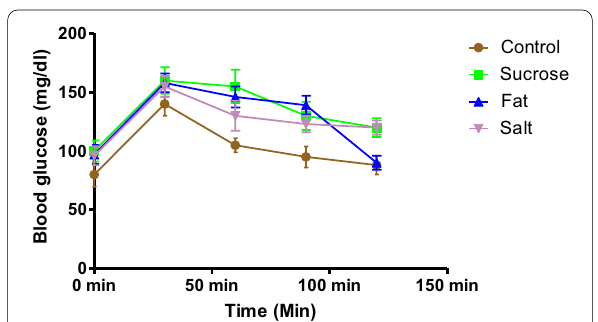
Fig. 1 The effect of high fat, high sucrose and high salt diet on the blood glucose level of experimental rats. Data are expressed as mean SEM ( n 10) ± =